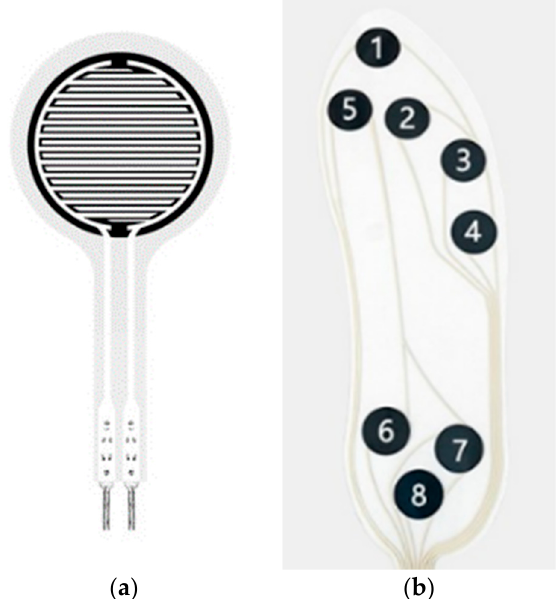
Figure 2. Film pressure sensor and insole configuration. ( a ) Thin-film pressure sensor MD30-60; ( b ) insole sensor configuration (the number 1-8 is the sensor arrangement number).